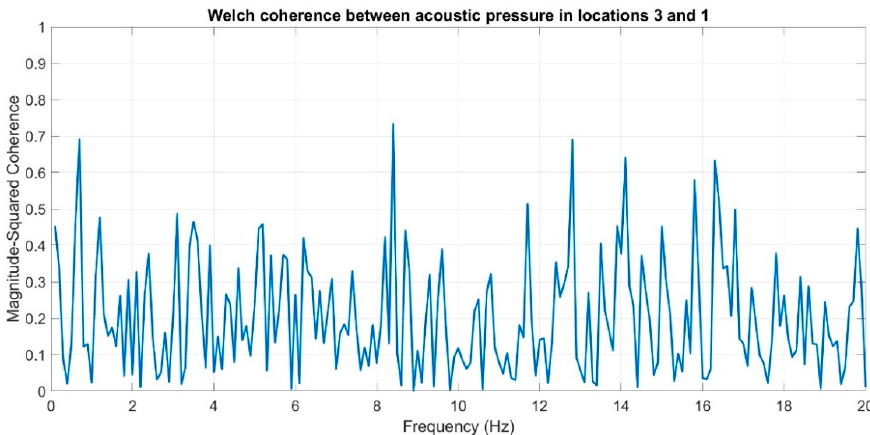
Figure 17. Coherence estimate via the Welch method for acoustic pressures in locations 2 and 1. The coherence above 0.75 is marked with red line.